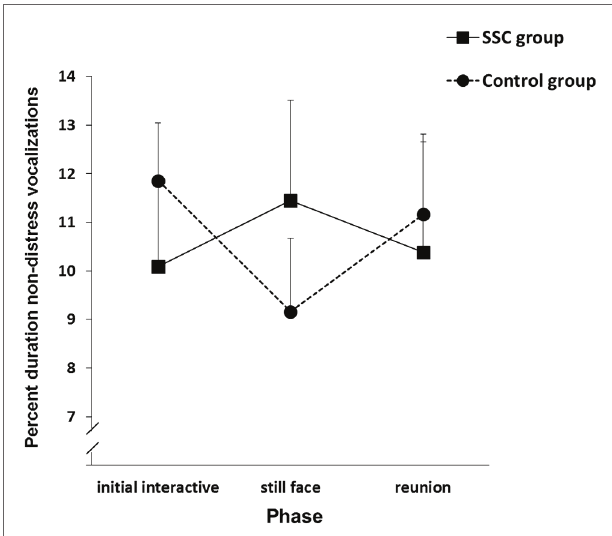
FIGURE 3 | Infants’ non-distress vocalizations in the SSC and control groups during each phase of the Still Face Task at the 3-month visit. Vertical bars represent standard errors. Adapted from Bigelow and Power (2012, p. 247). Copyright © 2012, with permission from